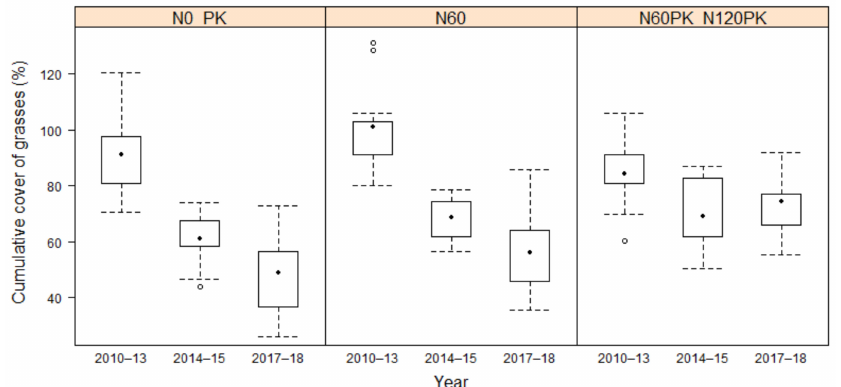
Figure 5. The minimal adequate model for the effect of fertilization treatment and time on the cumulative cover of grasses with different fertilization treatments between 2010 and 2018 (except 2016).